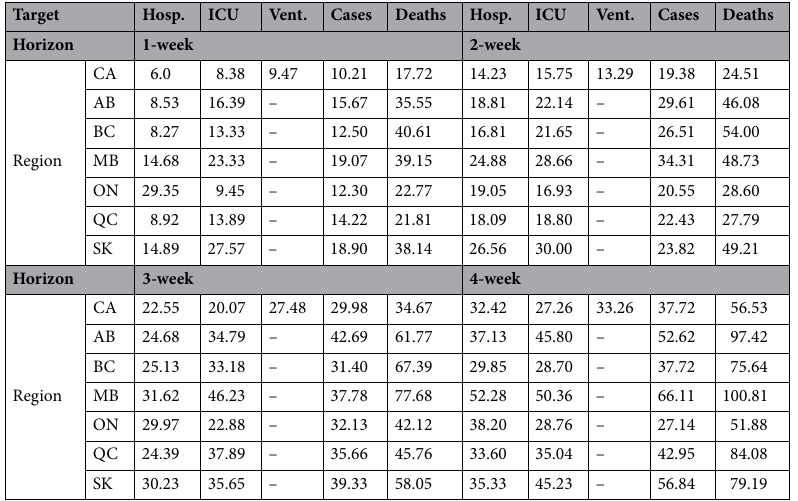
Table 5. MAPEs (%) of TCN’s forecasts during the 40 weeks between 2 Oct 2020 and 2 July 2021 (recall ventilator data is not available for the provinces).